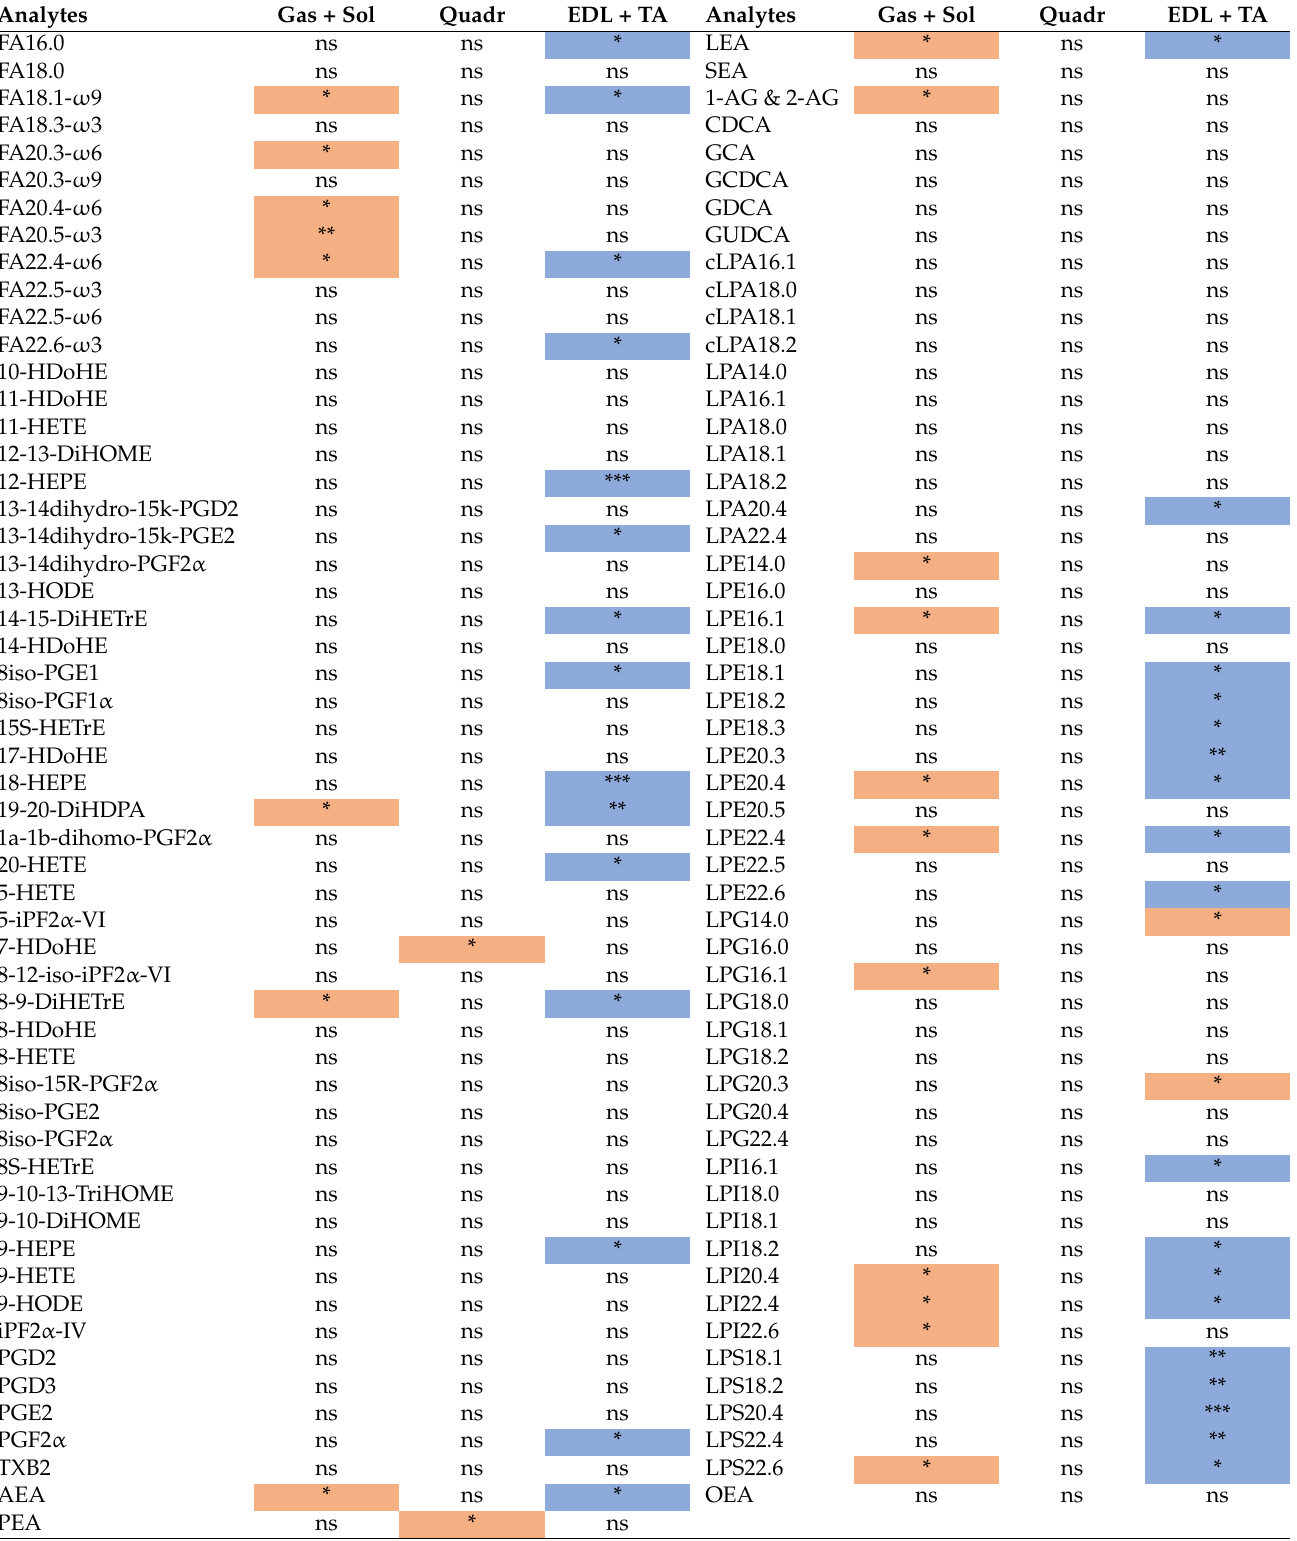
Table 1. The effect of sample collection speed on lipid metabolites stability in different muscle types (n =